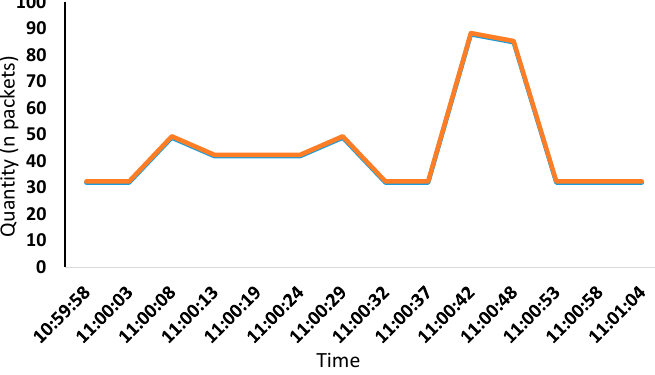
Figure 8. Database access analysis of query actions.